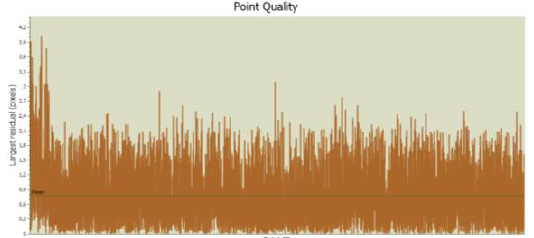
Figure 12. The largest residual value and the average residual per object point observed in pixels